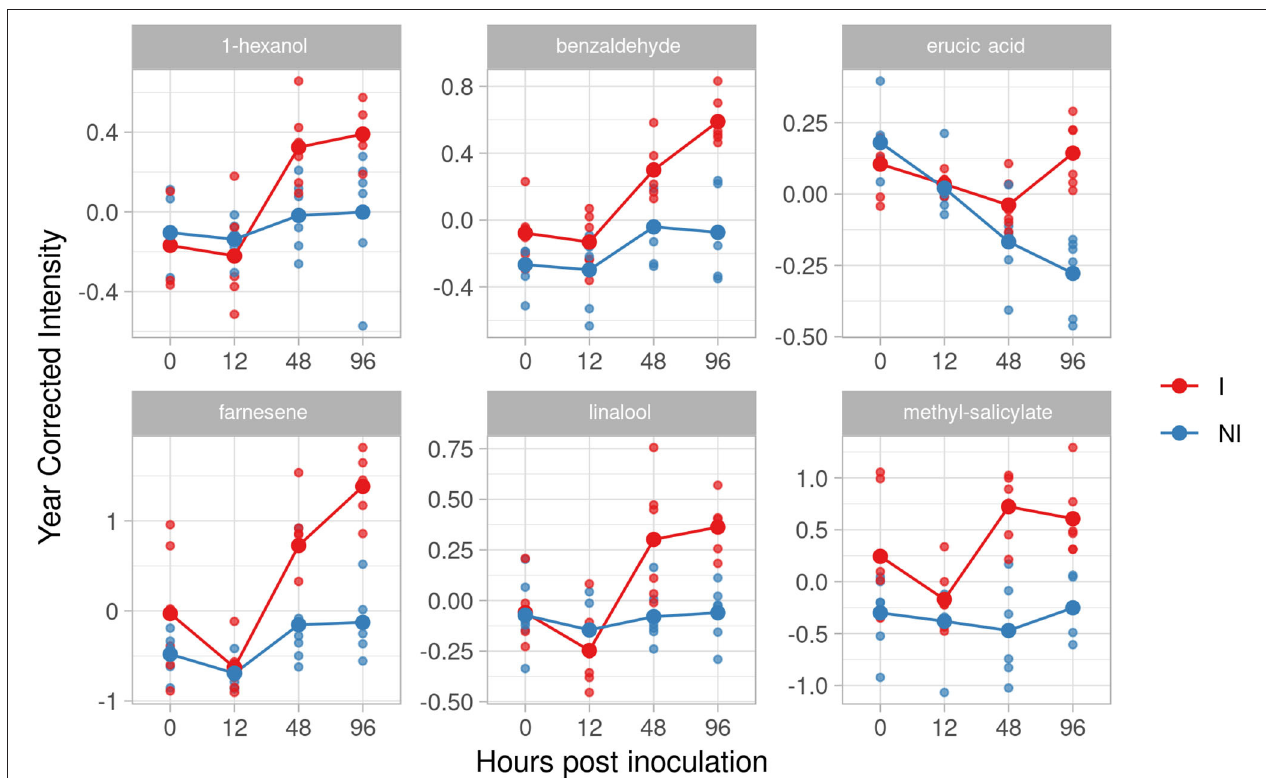
FIGURE 5 | Graphs for specific putative biomarkers of resistance to Plasmopara viticola in inoculated (Red) and not inoculated (Blue) Bianca genotype. Values of the 2 years are reported subtracting the year’s effect. I, inoculated; NI, not inoculated.